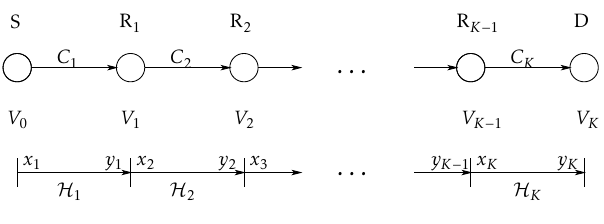
Figure 2. System model of K -hop cascaded directed relay networks with single node at each layer, and component link · · · , C } capacity set { C 1 , C 2 , K